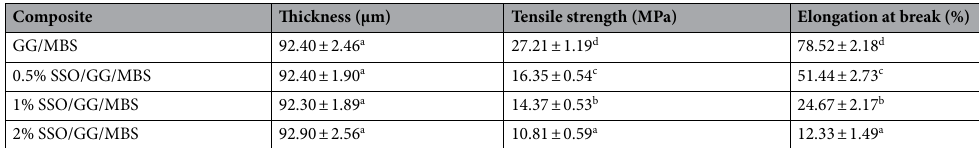
Table 1. Mechanical properties of GG/MBS and SSO/GG/MBS composite films. Data expressed as mean ± standard deviation of five replicates. Different lowercase letters (a–d) in the same column indicate a significant difference ( P ≤ 0.05) by Duncan’s multiple range test. GG guar gum, MBS mung bean starch, SSO sunflower seed